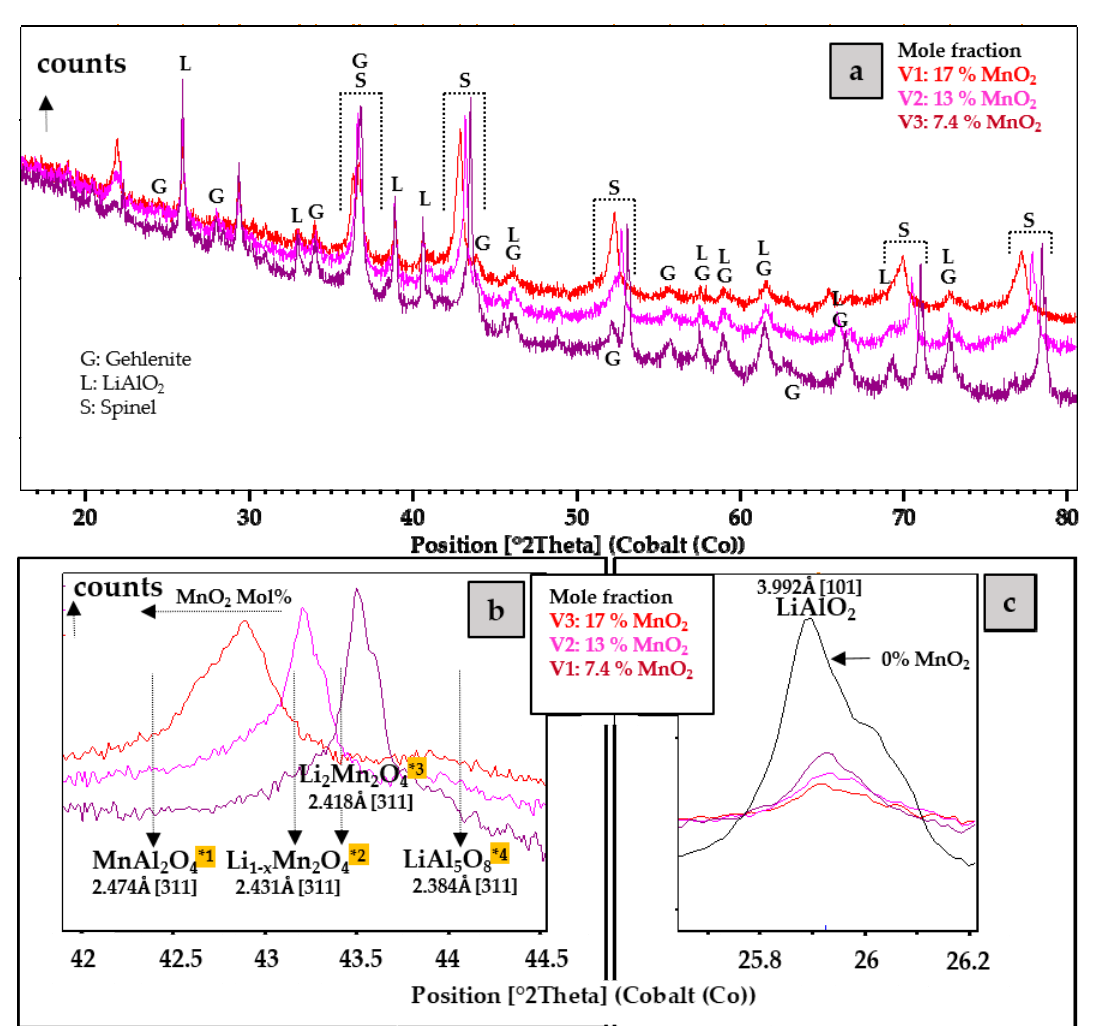
Figure 4. ( a ) Powder X-ray diffraction (PXRD) of the solidified melt. G: Gehlenite, S: Spinel, L: LiAlO 2 . ( b ): Enlarged section of the main spinel peak. * 1: the position of the main peak of MnAl 2 O 4 from the ICDD-PDF2 no. 00-029-0880 [17], * 2: the position of the main peak of the Li (1 − x ) Mn 2 O 4 spinel from the ICDD-PDF2 no. 00-038-07891 [17], * 3: the position of the main peak of the Li 2 Mn 2 O 4 spinel from the ICDD-PDF2 no. 01-084-1524 [17], * 4: the position of the main peak of the LiAl 5 O 8 spinel from the ICDD-PDF2 no. 00-038-1425 [17], ( C ) : Enlarged sections of the first two main LiAlO 2 peaks. In ( c ): for comparison, the LiAlO 2 main reflection of an Mn-free solidified melt with comparable Li 2 O content is presented.